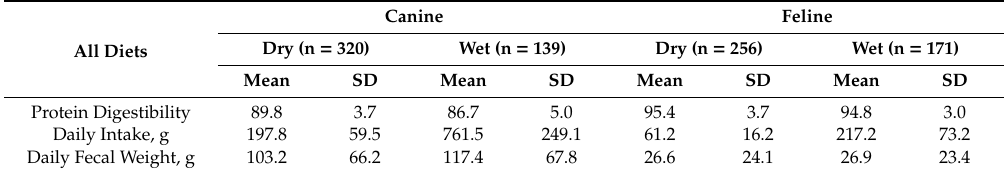
Table 3. Protein digestibility coe ffi cients, intakes and fecal weights of canine and feline studies.